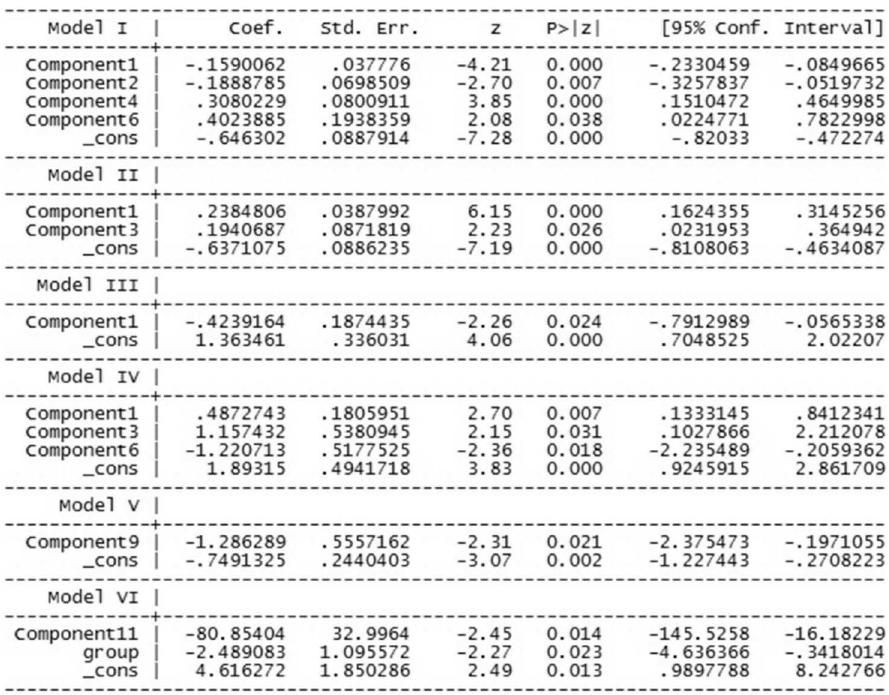
Table 4. Predictive models for pregnancy